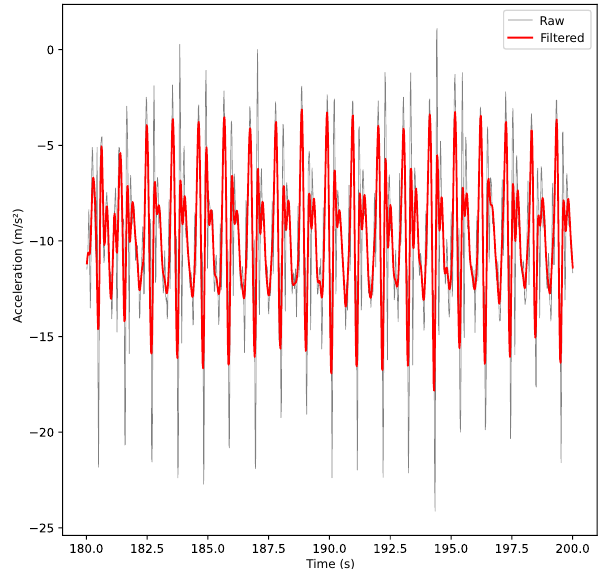
Figure 2. Example of raw data signal (grey) overlaid with filtered data signal (red), after applying a fourth-order low-pass Butterworth filter with cutoff frequency of 5